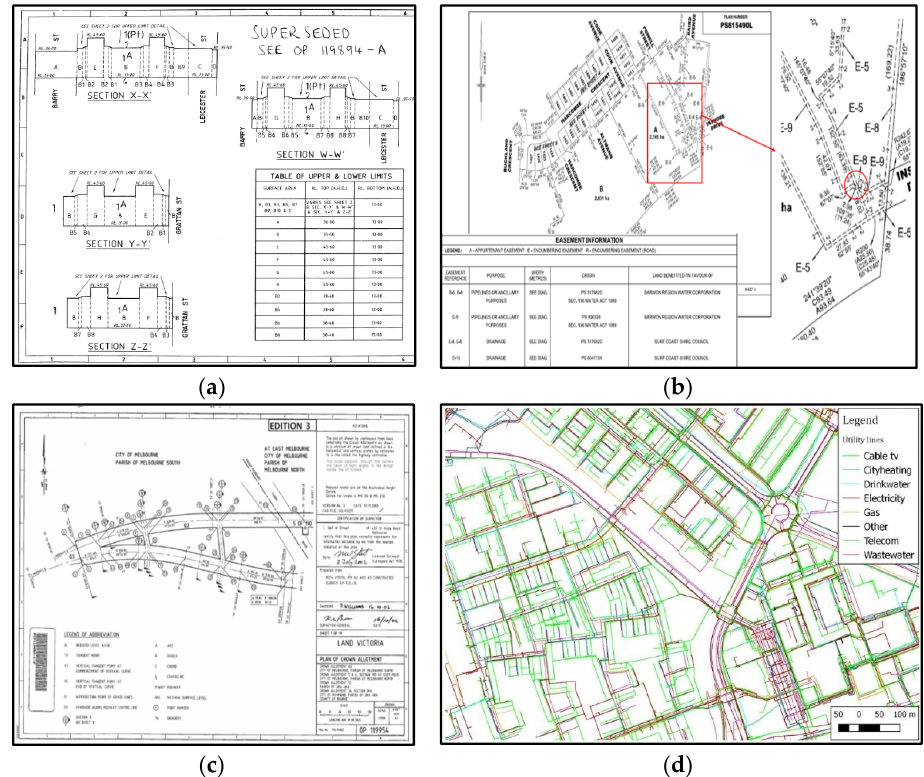
Figure 1. Current practices for managing legal and physical data of underground assets: ( a ) 2D cross-sectional diagrams for an underground car park with upper and lower limits, ( b ) easements as the ownership extent of underground utility networks in a subdivision plan, ( c ) a plan for an underground tunnel (plans source: [11]), and ( d ) a sample of utility data in a 2D environment without legal information, adapted with permission from ref. [12],